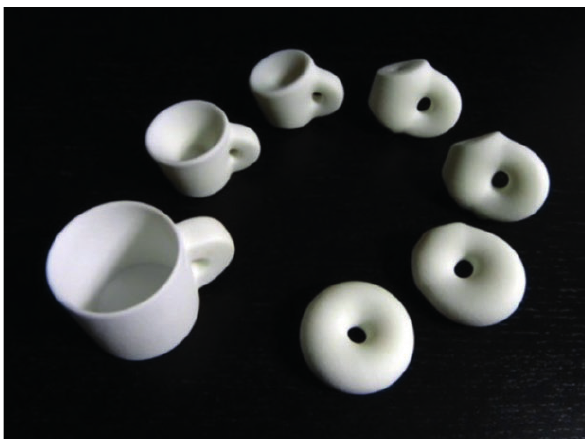
Figure 18. Homeomorphism between a donut, a sphere with one handle and a cup. Image from Roy and Kesselman, ArXiV 2201.06923.